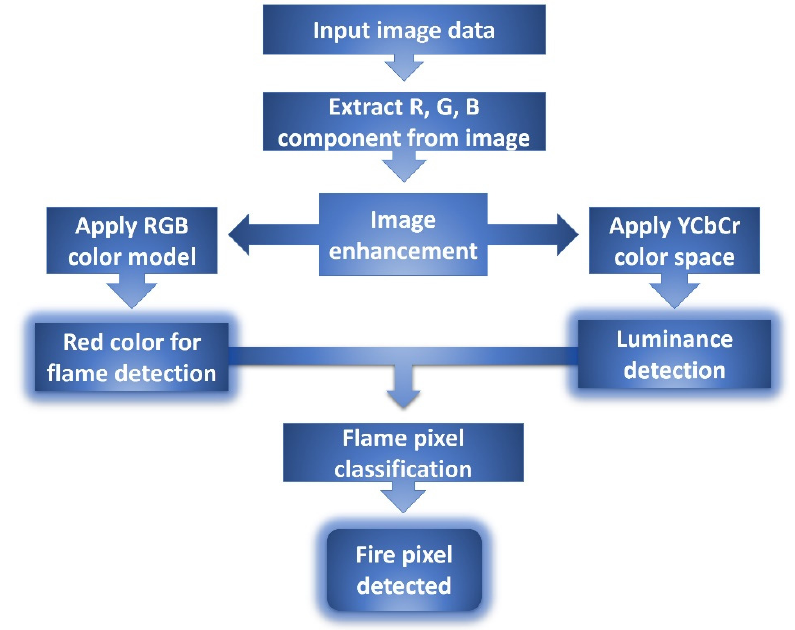
Figure 8. Flow chart for fire pixel detection using RGB and YCbCr color models.